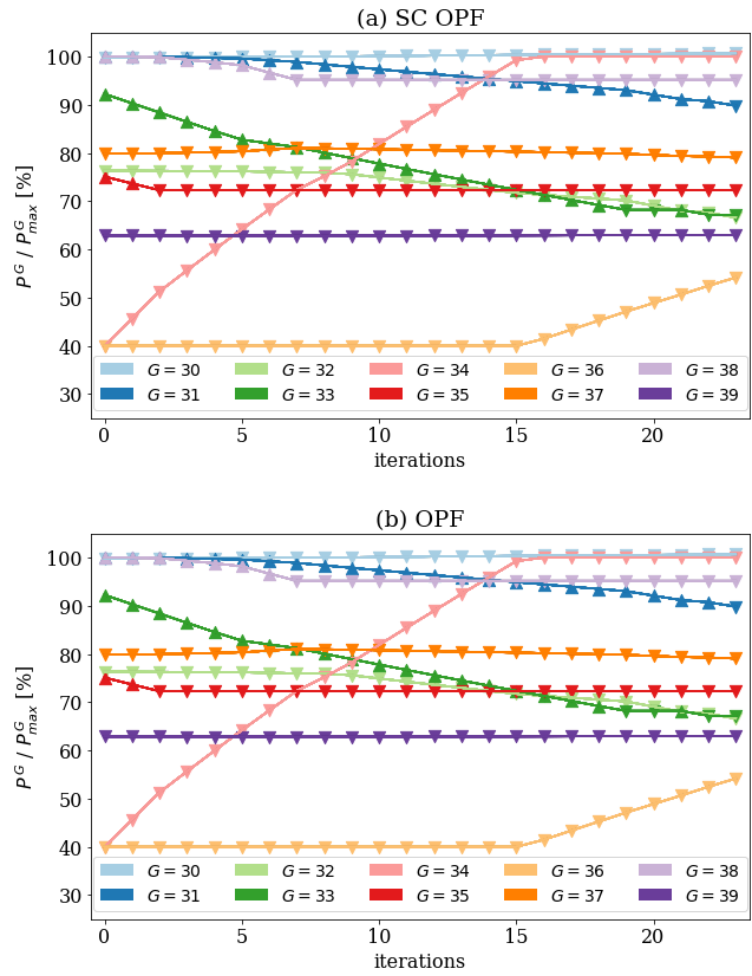
Figure 6. The active power values ( P G / P G max ) obtained in the risk optimization process for SC OPF ( a ) and OPF ( b ) scenarios and for every generator in each iteration (apart from Gen. 30 with constant generation level). The results include the identification of critical (CMs) and non-critical (NMs) machines, depicted by upward and downward triangles,